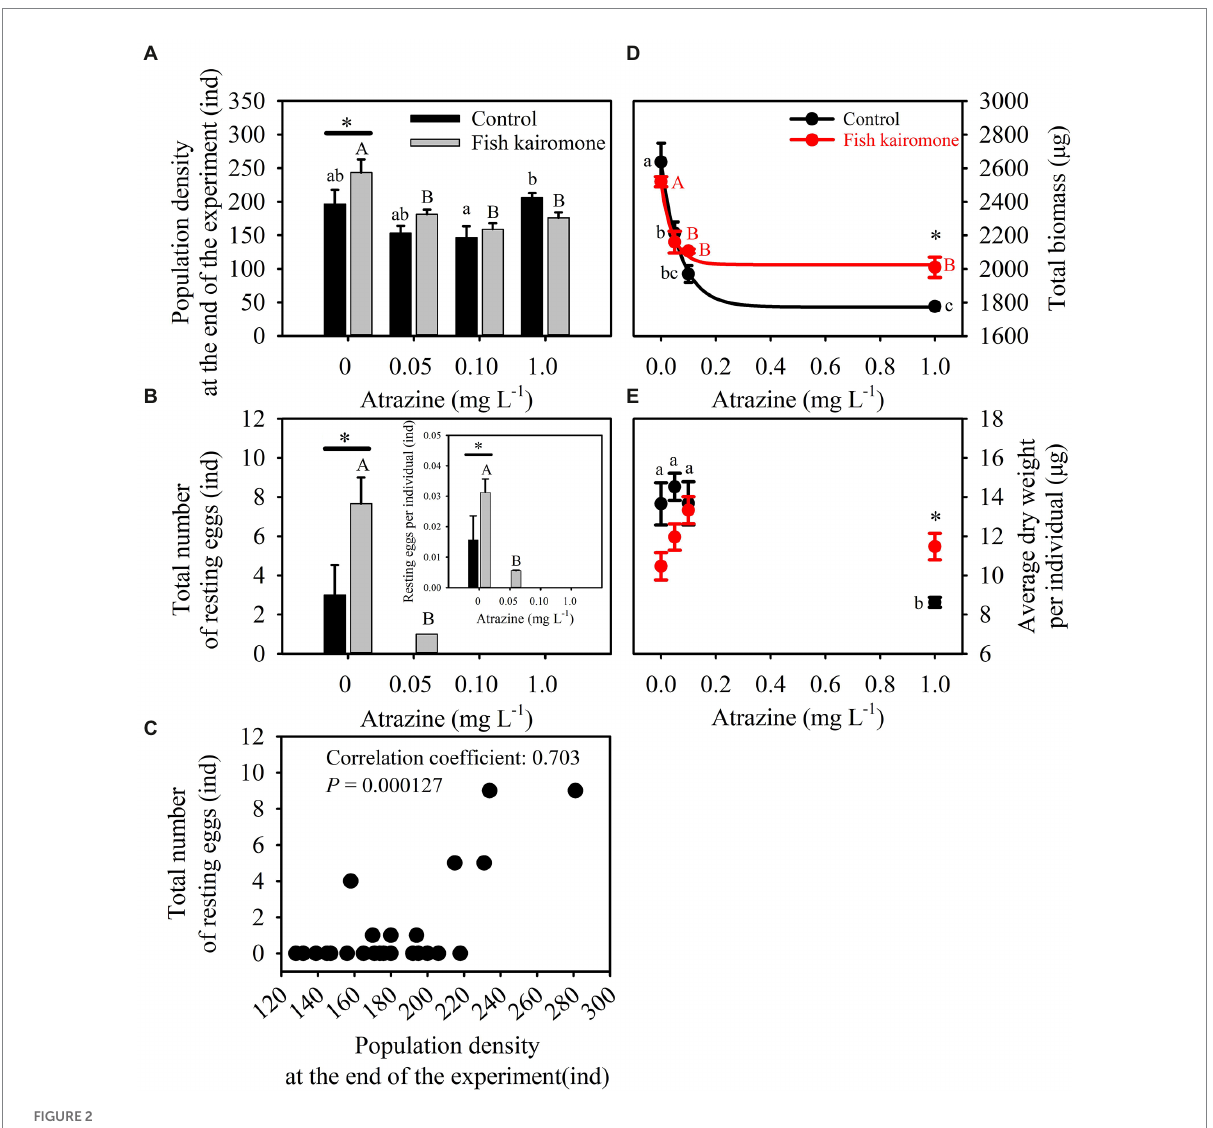
FIGURE 2 Population traits of D. pulex under different treatments. The correlation between resting eggs production and population density at the end of the experiment were calculated using the Pearson correlation coefficient. The total biomass at different treatments was fitted using the three- parameter exponential decay equation 0 r r me kA = + − . Asterisks indicate significant differences between control and kairomone treatments ( * p < 0.05), and lowercase and uppercase letters indicate differences among the control and fish kairomone treatment, respectively. The error bars indicate standard error. The results of two-way ANOVA are shown in Table